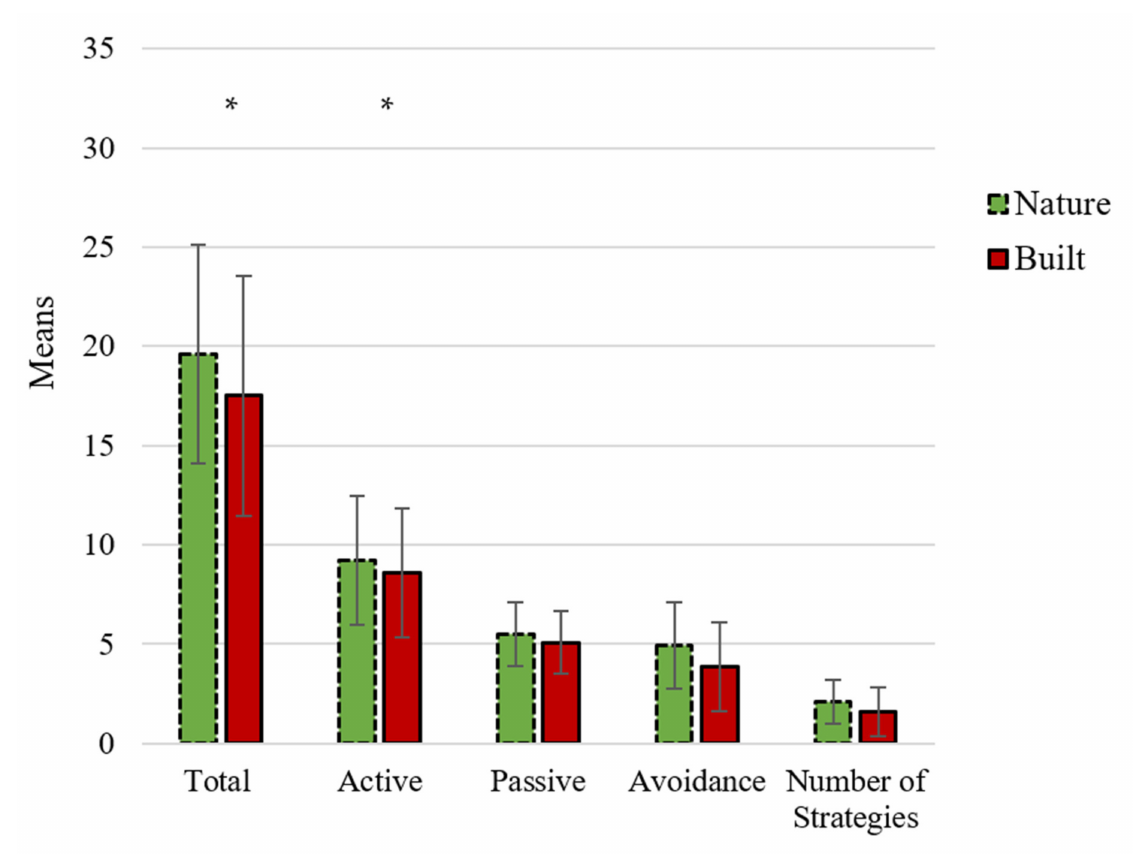
Figure 3. State Coping Scale (SCS) scores for the nature group and built group for Study 2. * p <